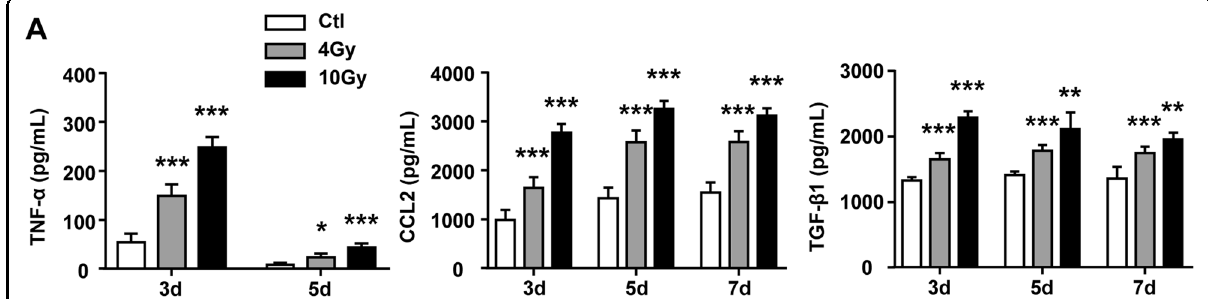
Fig. 3 Elevated expression of SASP components in supernatant of senescent BMMs. BMMs were exposed to IR at doses of 0 (ctl), 4, or 10 Gy. The supernatant of BMMs were collected at intervals after IR and in controls. A The protein levels of SASP components, including TNF- α , CCL2, and TGF- β 1 in supernatant of BMMs. Data are expressed as mean ± SEM of fi ve independent experiments, *** P < 0.001, ** P < 0.01, and * P < 0.05 compared with the corresponding